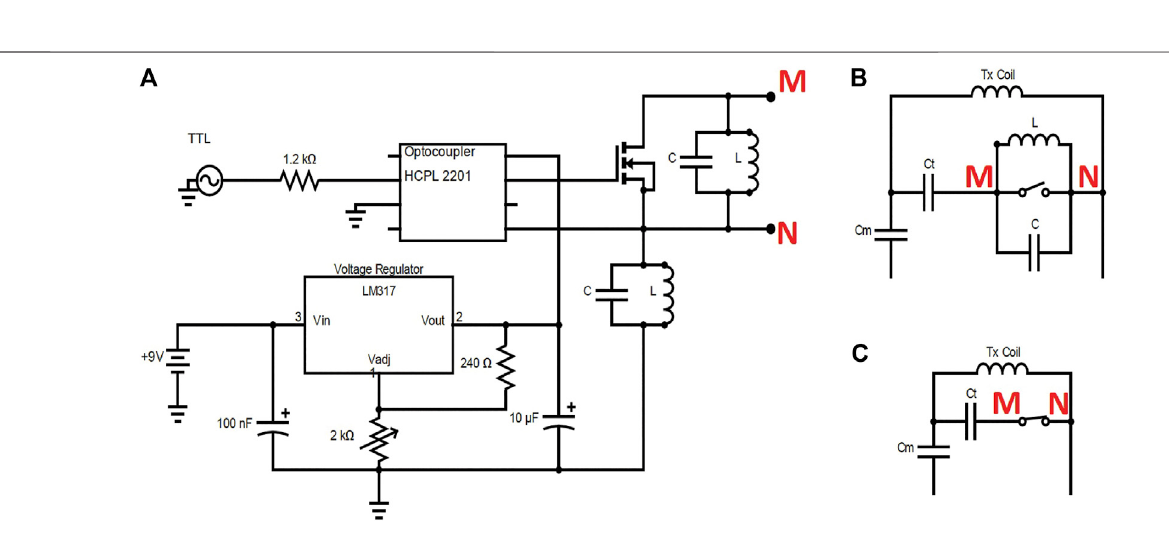
Frontiers in Physics |